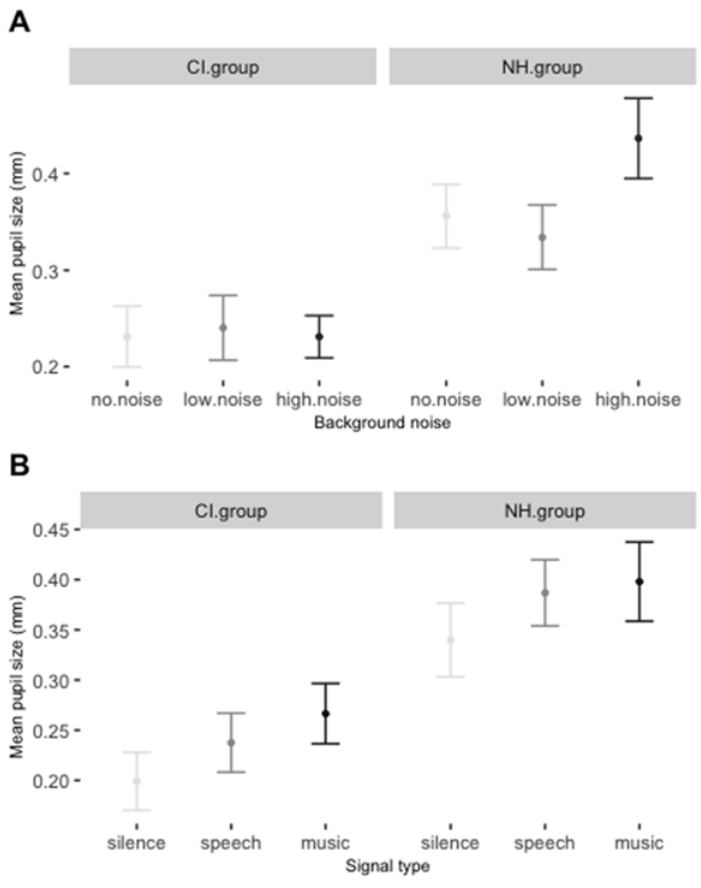
Figure 2. ( A ) Mean pupil responses per group with noise as the averaging factor. ( B ) Mean pupil responses per group with signal as the averaging factor. Error bars represent standard error rates.